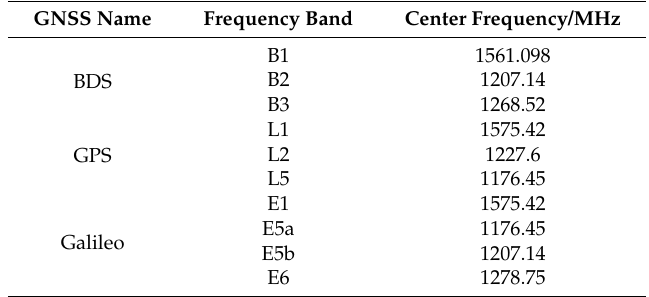
Table 1. The center frequencies of different GNSS. BDS, BeiDou navigation satellite System.